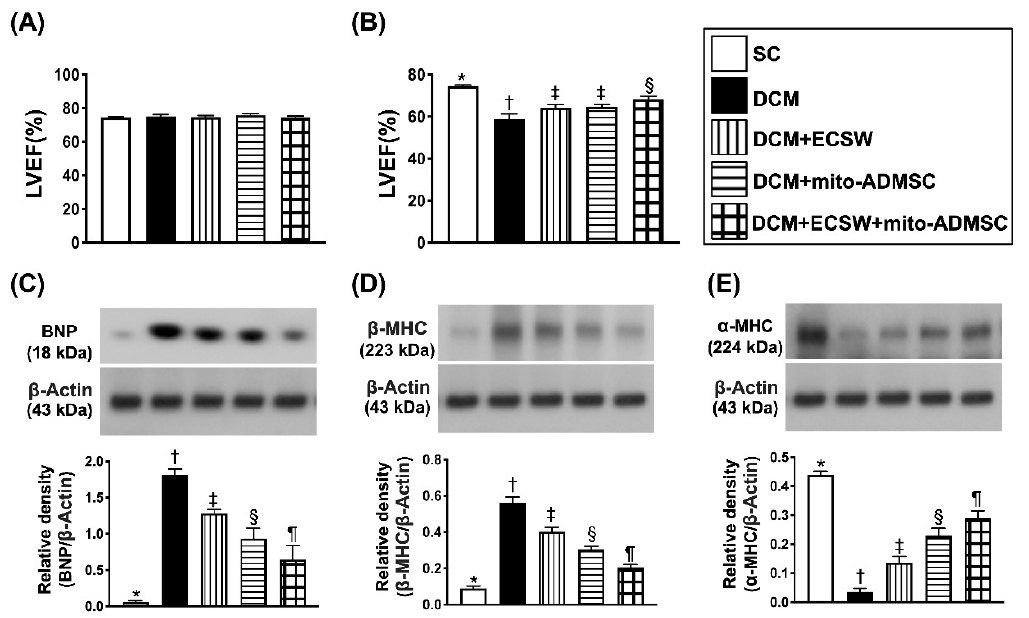
Figure 7. Heart function and biomarkers of heart failure and pressure overload in LV myocardium 7 weeks after DCM induction. ( A ) Left ventricular ejection fraction (LVEF) by day 0, p > 0.5. ( B ) LVEF by day 49, * vs. other groups with different symbols (†, ‡, §), p < 0.0001. ( C ) Protein expression of brain natriuretic peptide (BNP), * vs. other groups with different symbols (†, ‡, §, ¶), p < 0.0001. ( D ) Protein expression of beta myelin heavy chain (ß-MHC), * vs. other groups with different symbols (†, ‡, §, ¶), p < 0.0001. ( E ) Protein expression of α -MHC, * vs. other groups with different symbols (†, ‡, §, ¶), p < 0.0001. All statistical analyses were performed by one-way ANOVA, followed by Bonferroni multiple comparison post hoc test ( n = 6 for each group). Symbols (*, †, ‡, ¶) indicate significance (at 0.05 level). SC = sham control; DCM = dilated cardiomyopathy; ECSW = extracorporeal shock wave; mito = mitochondria.